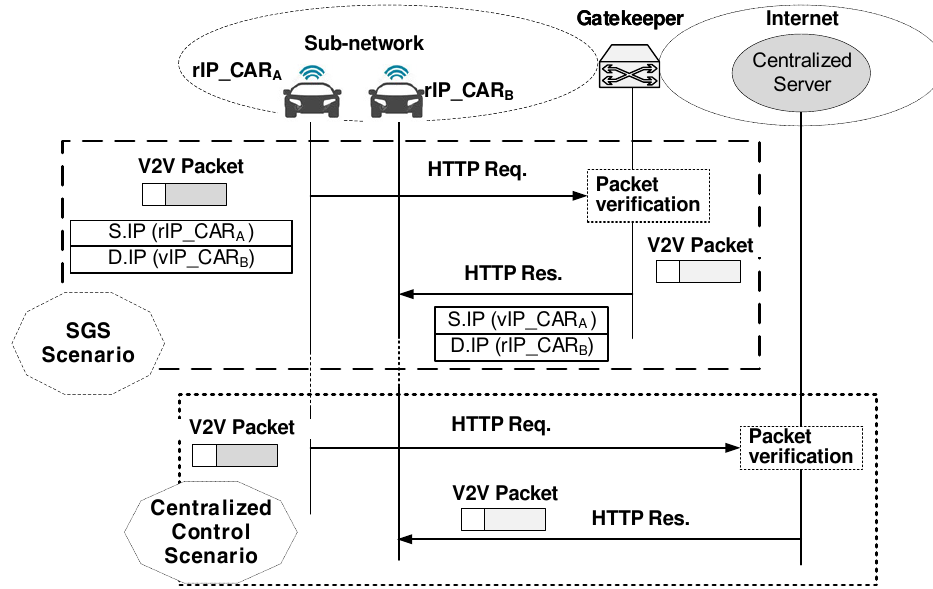
Figure 9. Performance measurements with the SGS